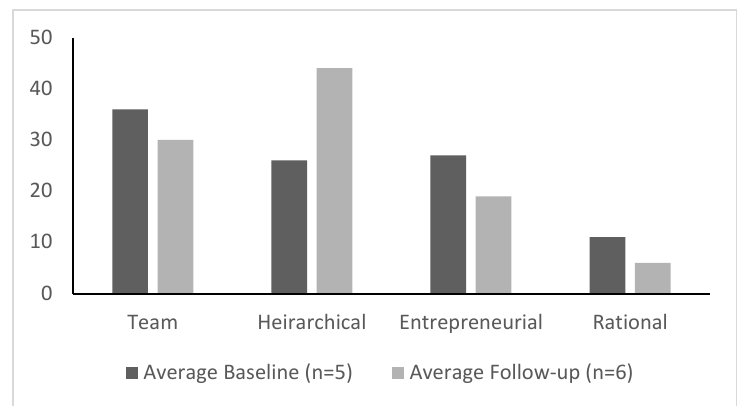
Figure 5. Average distribution of perceived team culture at baseline and follow-up.